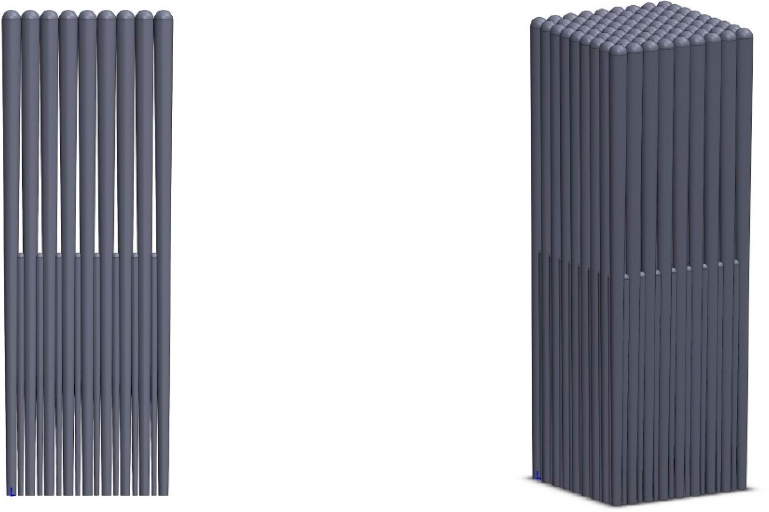
Figure 2. The three-dimensional columnar structure EB-PVD coating model.